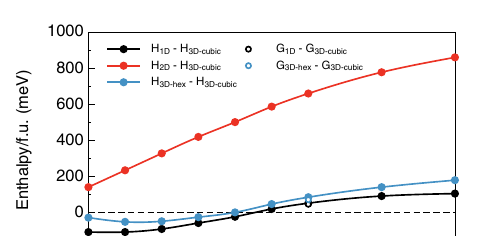
Fig. 2 Enthalpy differences as functions of hydrostatic pressure. Solid black circles: enthalpy differences between 1D and 3D-cubic structures of N (CH 3 ) 4 SnI 3 . Solid red circles: enthalpy differences between 2D and 3D- cubic structures. Solid blue circles: enthalpy differences between 3D-hex and 3D-cubic structures. The calculated Gibbs free energy differences between 3D-cubic and 1D (open black circle), 3D-hex (open blue circle) structures at 6 GPa and 300 K are also marked.